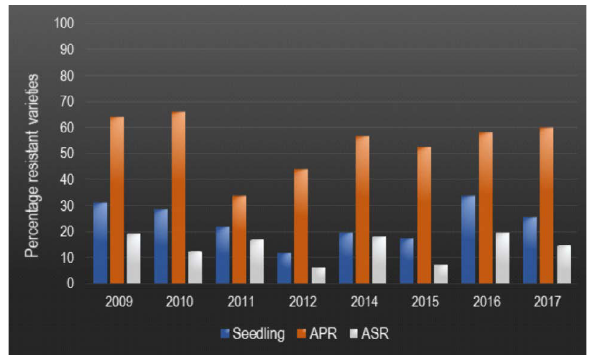
The frequency of South African wheat varieties expressing a low seedling response, adult plant resistance (APR) and true all-stage resistance (ASR) to stem rust over 8 years. In 2009 and 2010, entries were tested with Puccinia graminis f. sp. tritici pathotype UVPgt59 (TTKSP), and since 2011 with the more virulent UVPgt60 (PTKST) pathotype.